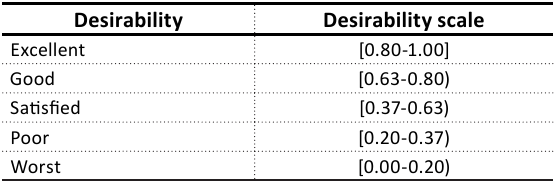
Table 3. Harrington’s function rating scale